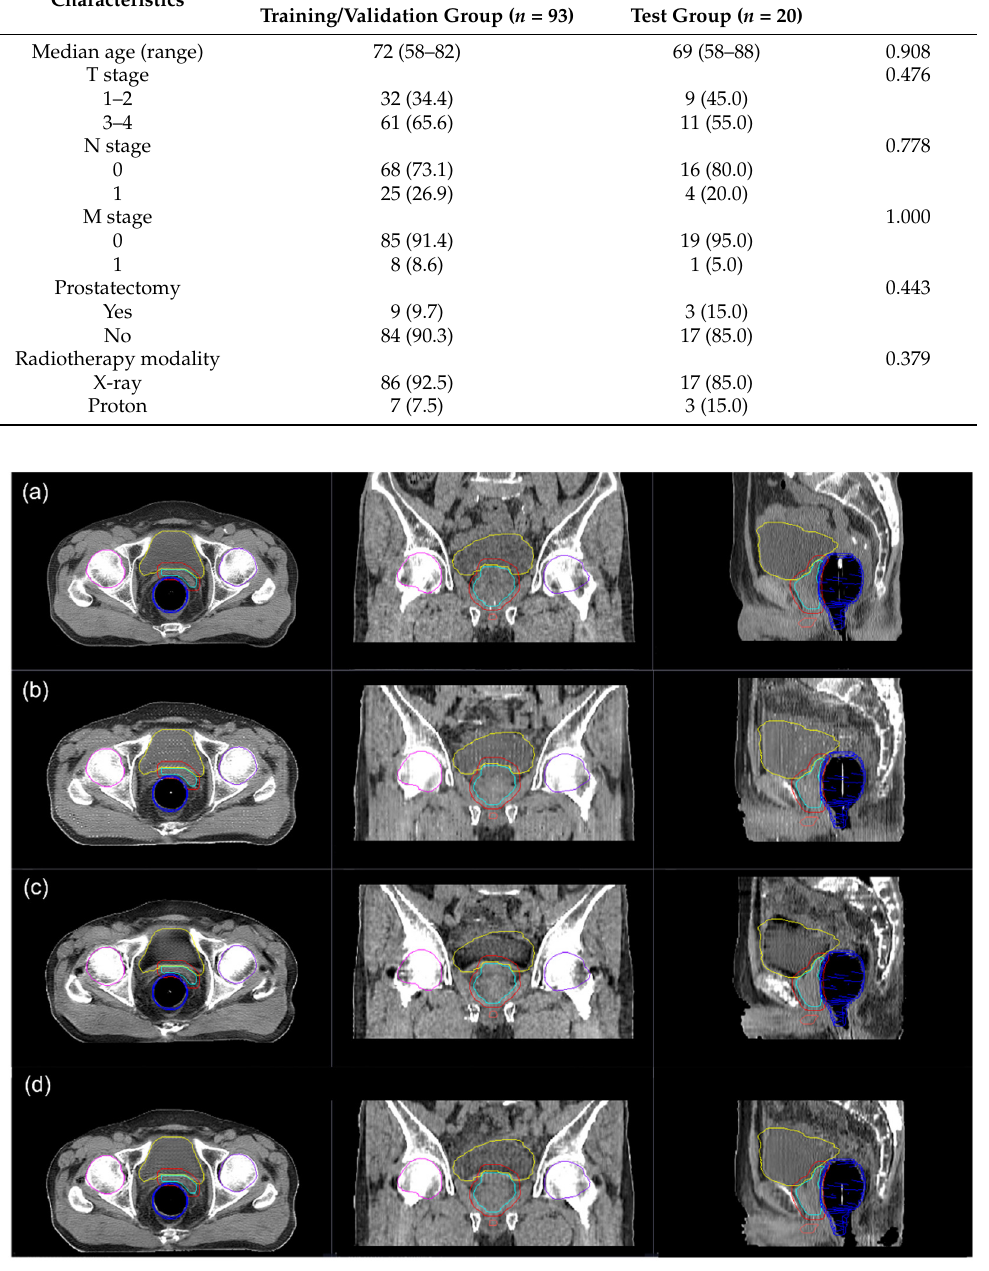
Figure 2. Example of original ( a ) and synthetic computed tomography generated from generative and adversarial network (GAN) ( b ), cyclo-consistent GAN ( c ) and reference-guided cyclo-consistent GAN ( d ) (left; axial view, middle; coronal view; right sagittal view) .